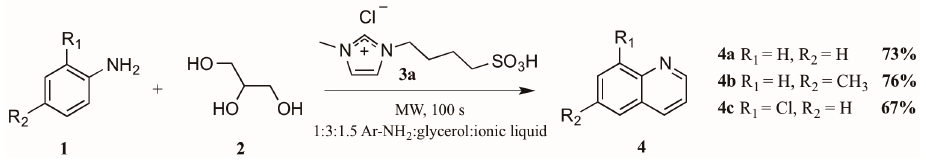
Figure 4. Skraup reaction in ionic liquid medium under microwave irradiation.